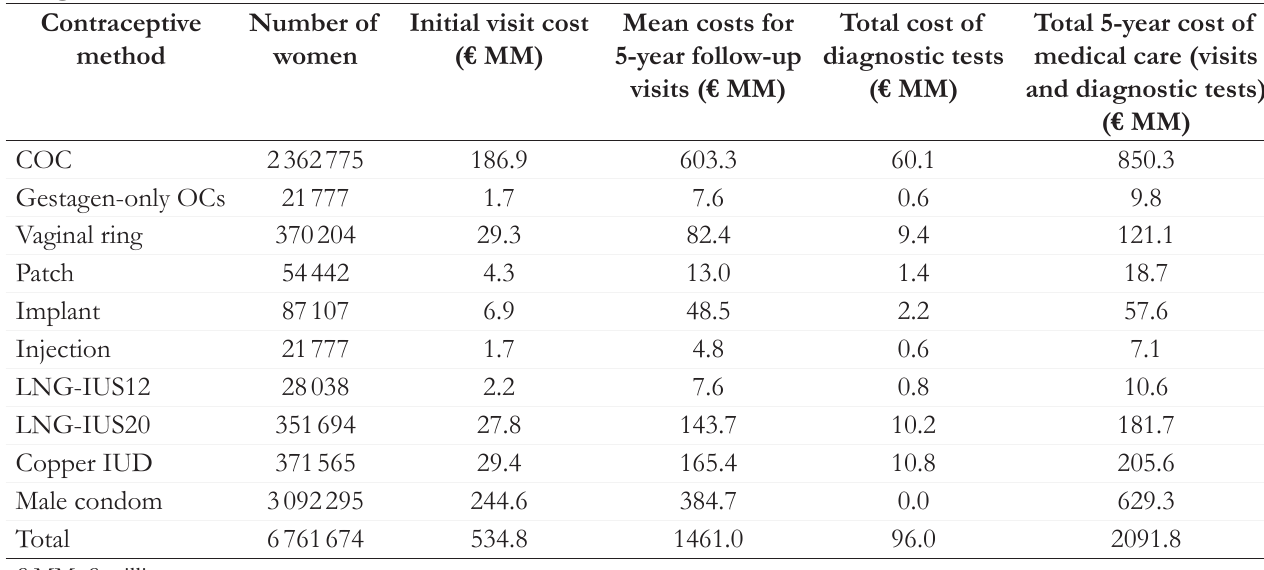
Table 4. Total Cost of Associated Medical Management (initial and follow-up consultations and diagnostic tests)